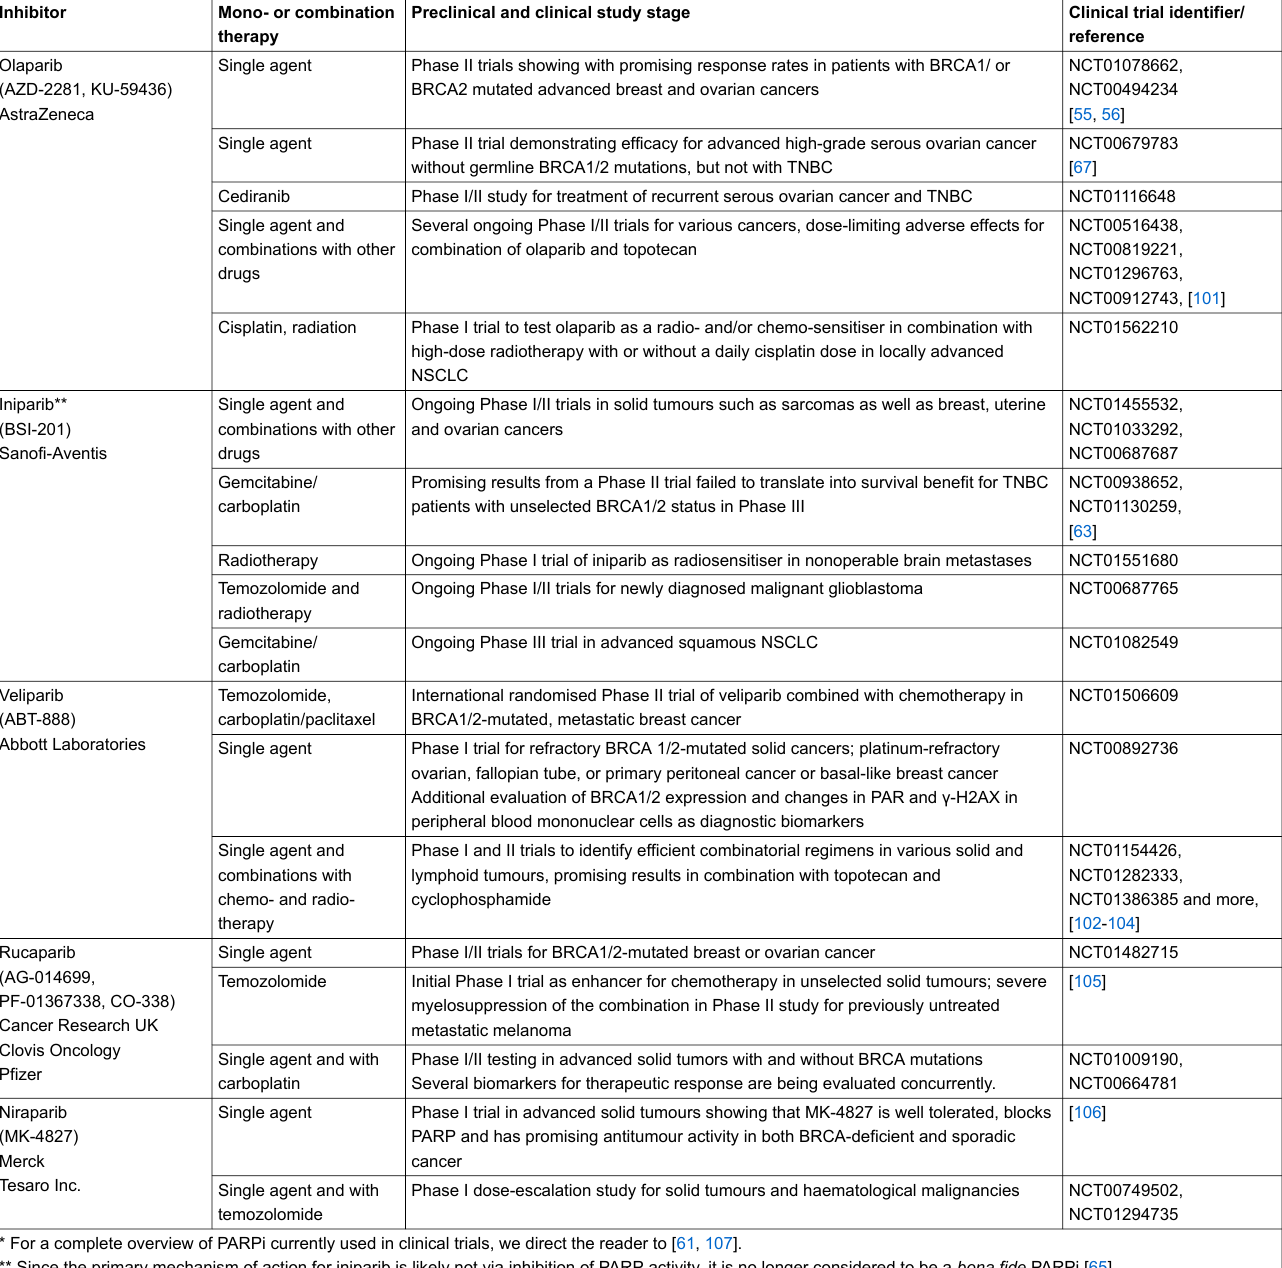
Table 2: PARP inhibitors in preclinical or clinical development for cancer therapy*. Inhibitor Mono- or combination